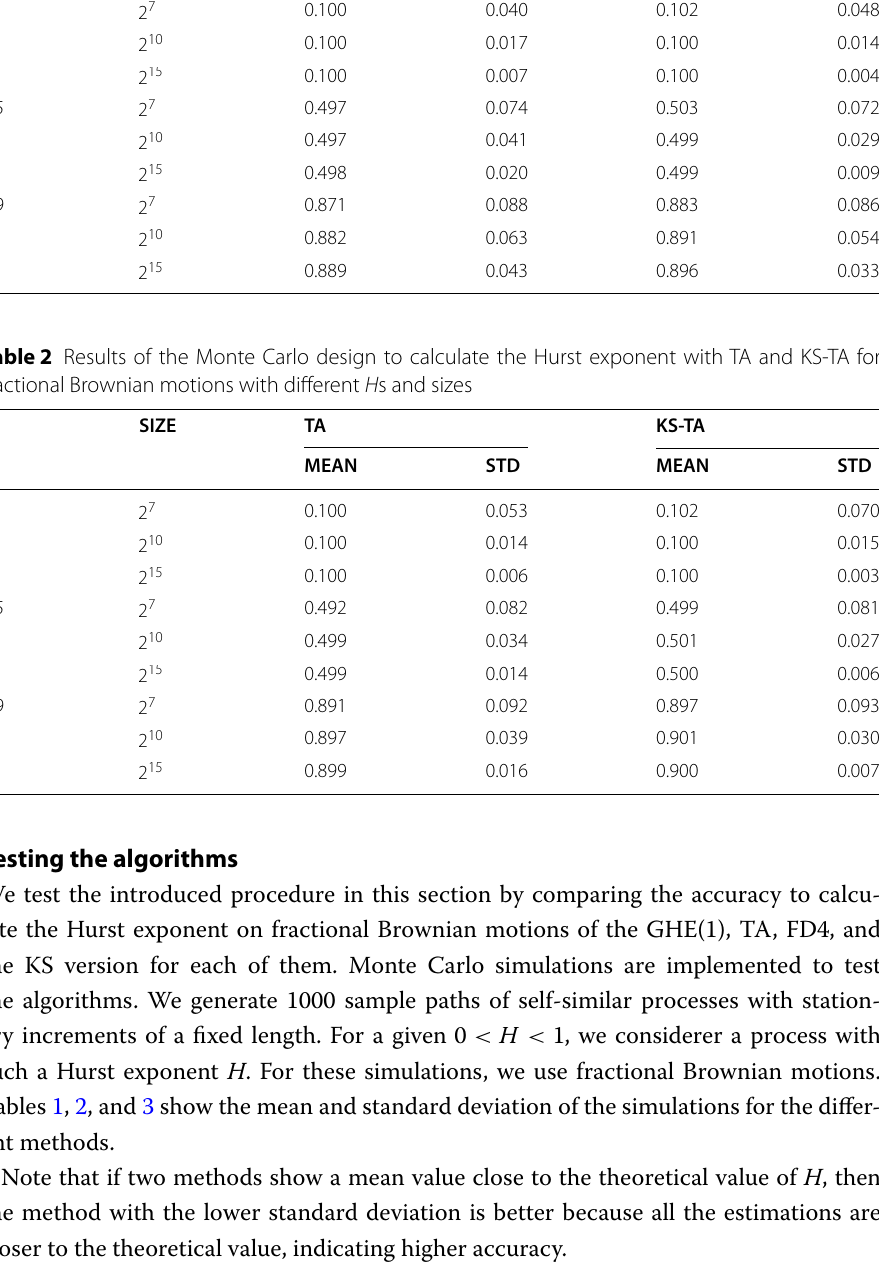
Table 1 Results of the Monte Carlo design to calculate the Hurst exponent with GHE(1) and KS‑GHE(1) for fractional Brownian motions with different H s and sizes H SIZE GHE(1) KS-GHE(1) 0.1